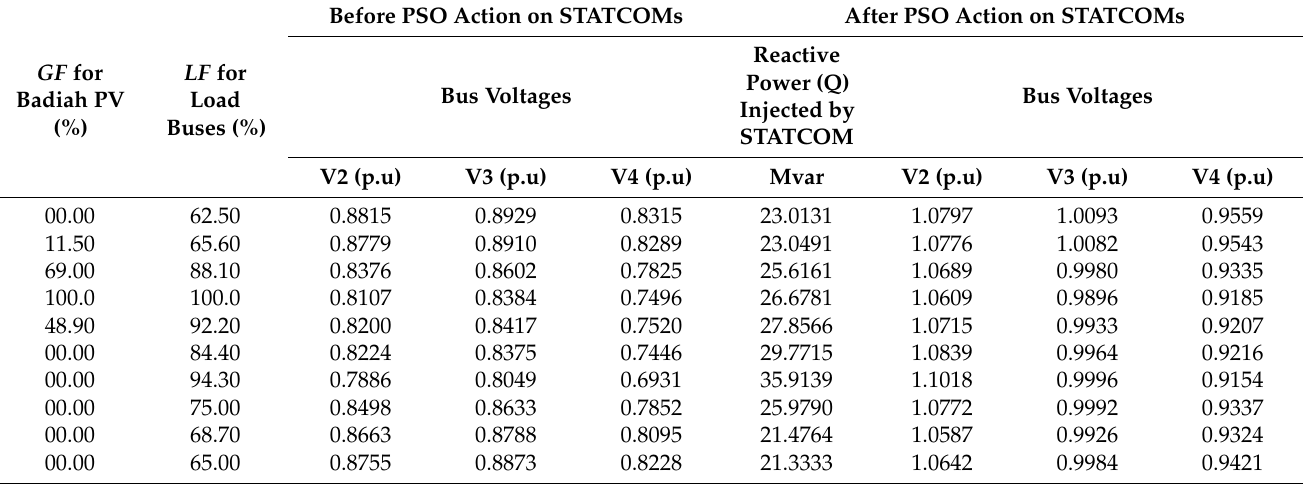
Table 8. PSO results using one STATCOM at TPV3 bus of Badiah PV Farm.